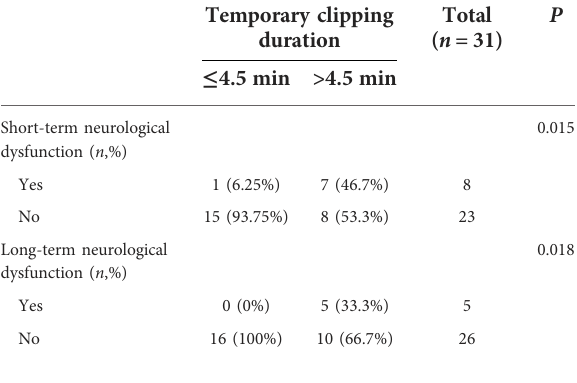
TABLE 4 Relationship between temporary clipping time and postoperative neurological